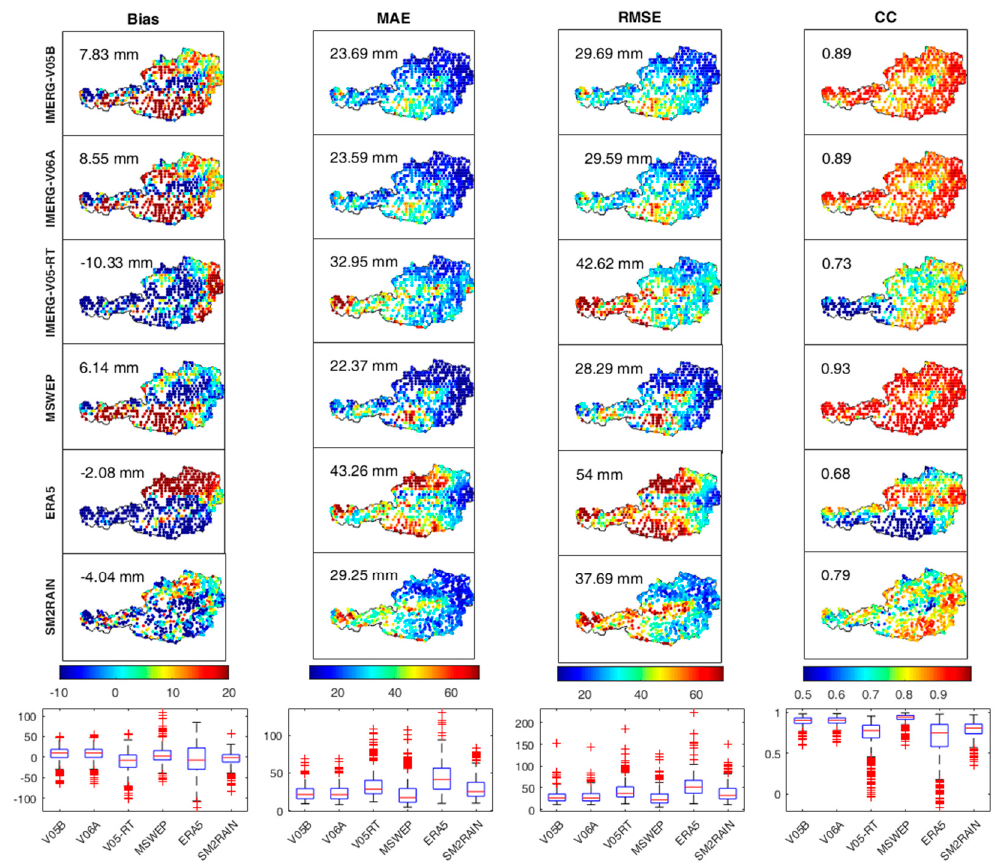
Figure 4. Statistical indices and for bias, CC, RMSE, and MAE from top to down rows, respectively, at monthly time scale for IMERG-V05B, IMERG-V06A, MSWEP, ERA5, and SM2RAIN. The center-line of each boxplot depicts the median value (50th percentile) and the box encompasses the 25th and 75th percentiles of the sample data, while the whiskers represent the extreme values, respectively.